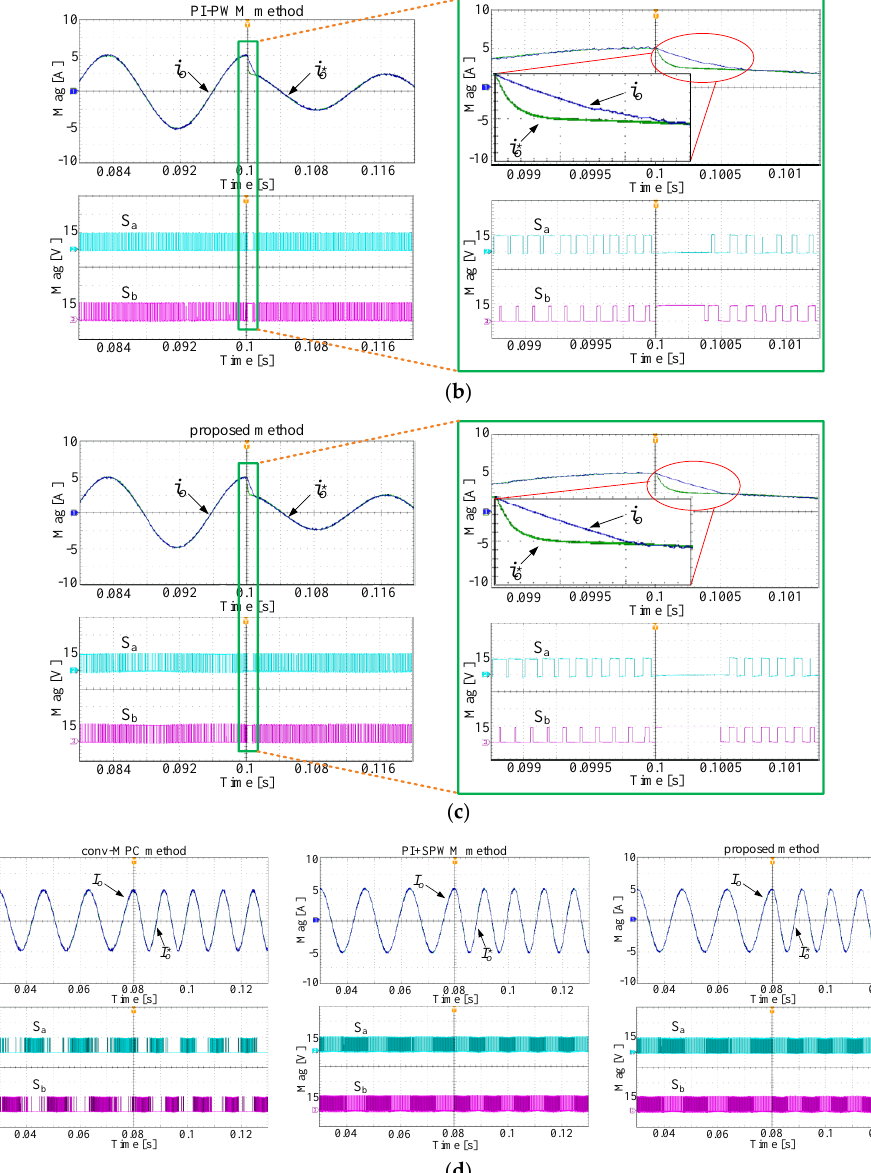
Figure 15. Experimental results of output current ( i o ), the reference current ( i o* ), and the upper switch state ( S a , S b ) by ( a ) conv-MPC ( T s = 33 μs); ( b ) PI-PWM method ( T sw = 200 μs); ( c ) the proposed method ( T s = 200 μs) during magnitude change (5 A → 2.5 A); ( d ) frequency change (60 Hz → 90 Hz). Experimental power data were measured to calculate power losses obtained by the three control methods, where each method was performed under the same input power and load conditions. The output power of each method was measured through an oscilloscope (MSO3054). The efficiencies of the conv-MPC, the PI-PWM, and the proposed method are 94.3%, 95.5%, and 95.4%, respectively, all of which are similar, just as in the simulation study.